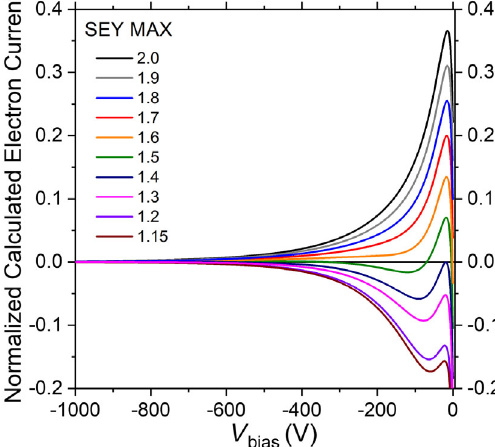
FIG. 12. Variation of the electron current vs V several SEY using Eqs. (10) and (11) with